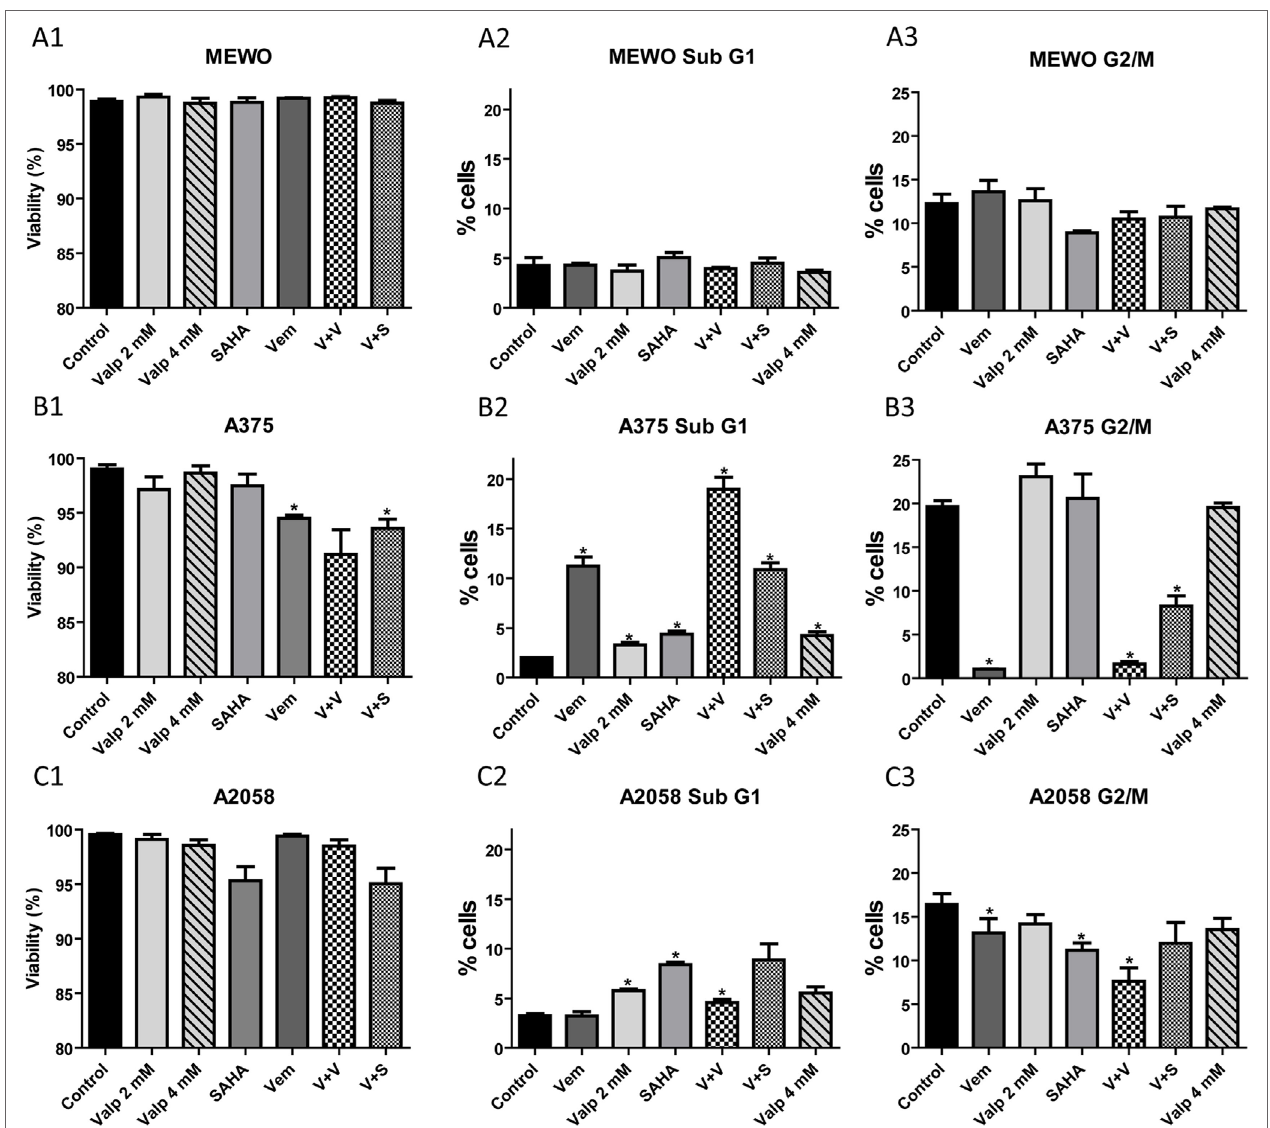
FigUre 5 | analysis of viability and cell cycle after treatment with histone deacetylase inhibitors alone and in combination with the BraF inhibitor, vemurafenib . Cells were treated with SAHA (1 µM), valproate (2 or 4 mM), and vemurafenib (0.5 µM) alone or in combination for 48 h. (a) The percentage of viable cells was determined by counting the number of total and non-viable cells. (B) The ratio of cells in sub-G1 and G2/M cell cycle phases was determined based on the cell’s DNA content. Data are means of three independent determinations. Significance compared to control is denoted by asterisks (* p < 0.05); two-tailed paired t